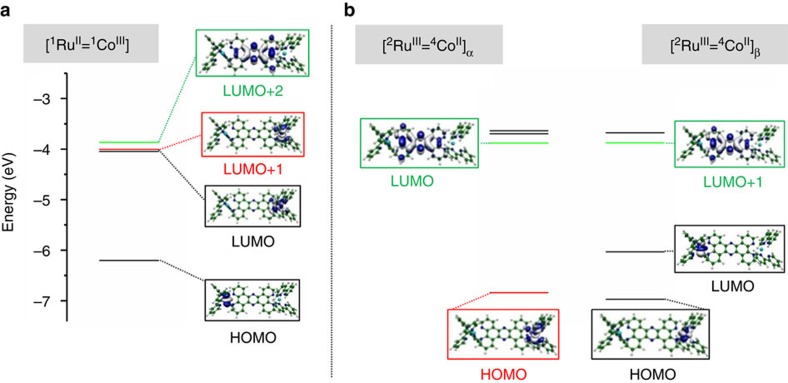
Low-lying electronically excited MOs and frontier MOs.These MOs have been obtained from DFT calculations for (a) the LS [1RuII=1CoIII] and (b) the HS [2RuIII=4CoII]α and [2RuIII=4CoII]β.